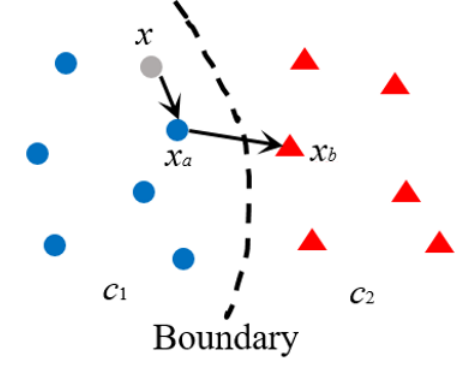
Figure 2. Diagram of the original DSA